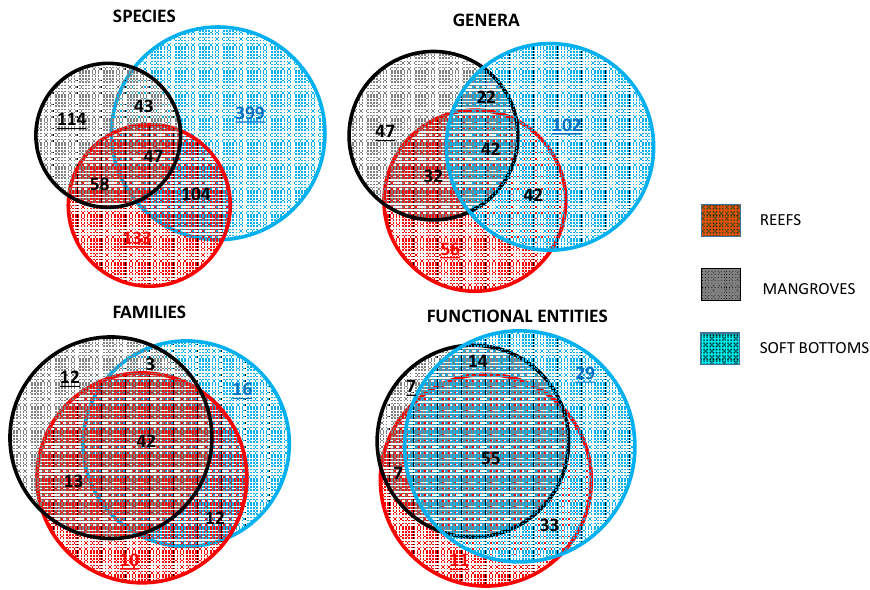
Figure 3. Venn diagrams indicating the overlap between the three assemblages (reefs, soft-bottoms, and mangroves) at four organization levels (species, genera, families, and functional entities). Proportions, totals, and statistical tests are given in Supplementary Materials Table S4. Colored underlined numbers correspond to exclusivity.